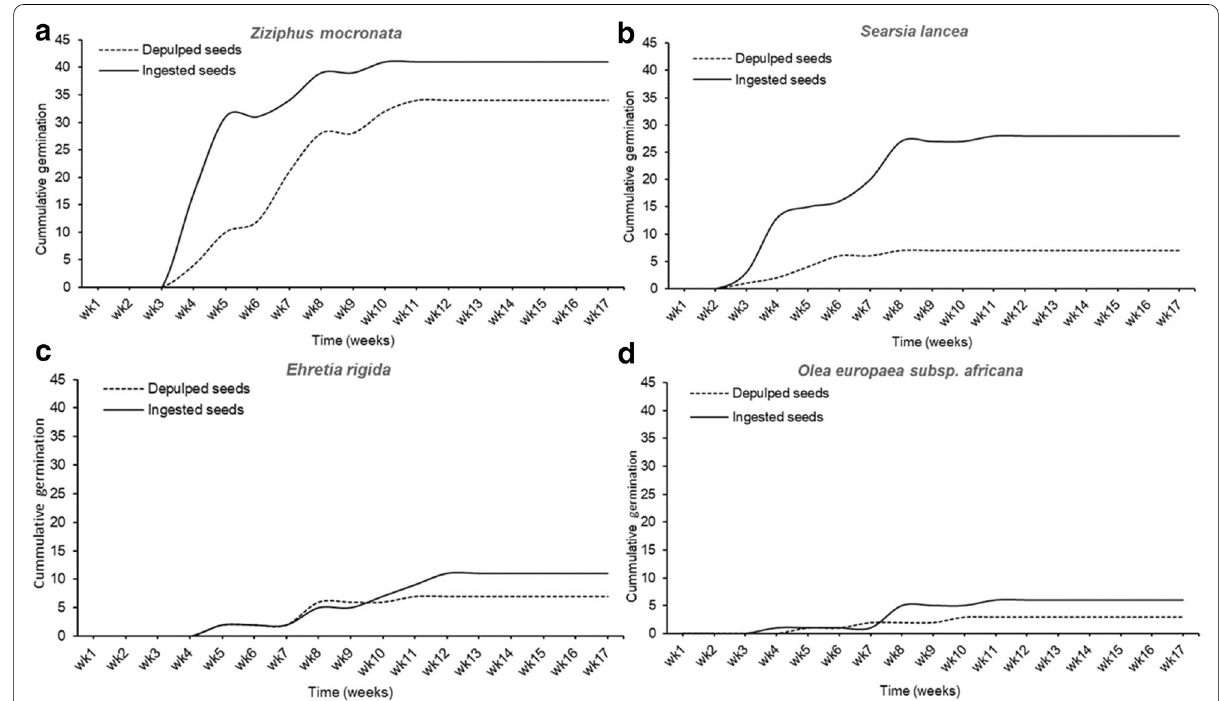
Fig. 3 Cumulative weekly seed germination between bird-ingested seeds and manually depuplped seeds for four native tree/shrub plant species ( A Z. mucronata , B S. lancea , C E. rigida , and D O. supsp. africana ). The ingested seeds were extracted from bird faecal and depulped seeds were extracted direct from the tree/shrub ripe fleshly